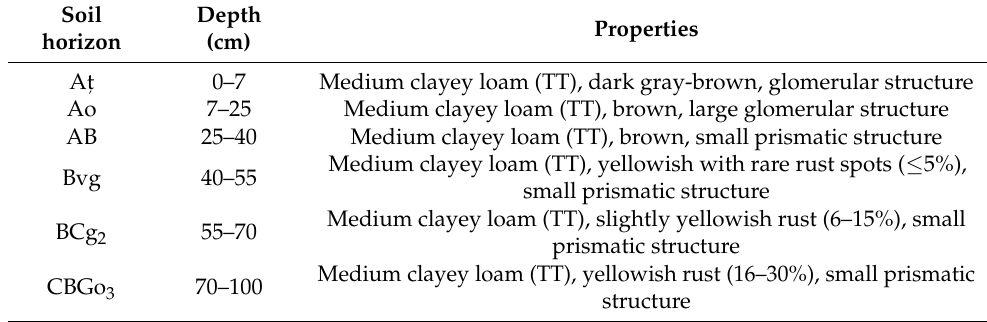
Table 4. Presentation of the soil profile horizons SP2, P816, pastures agricultural